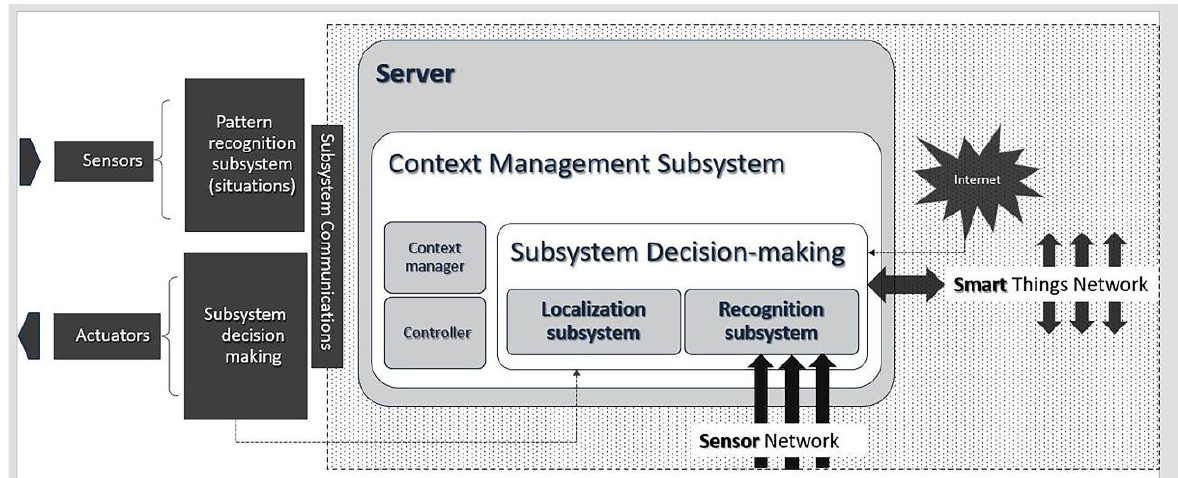
Figure 2. Structure of the information system of the smart environment .